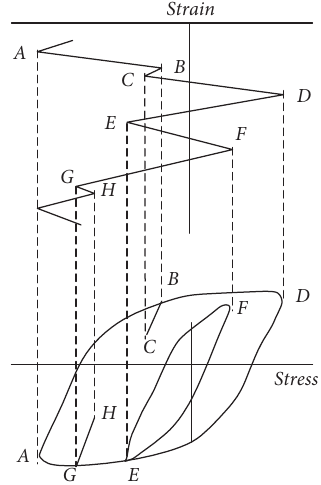
Figure 7: Stress-strain cycle hysteresis